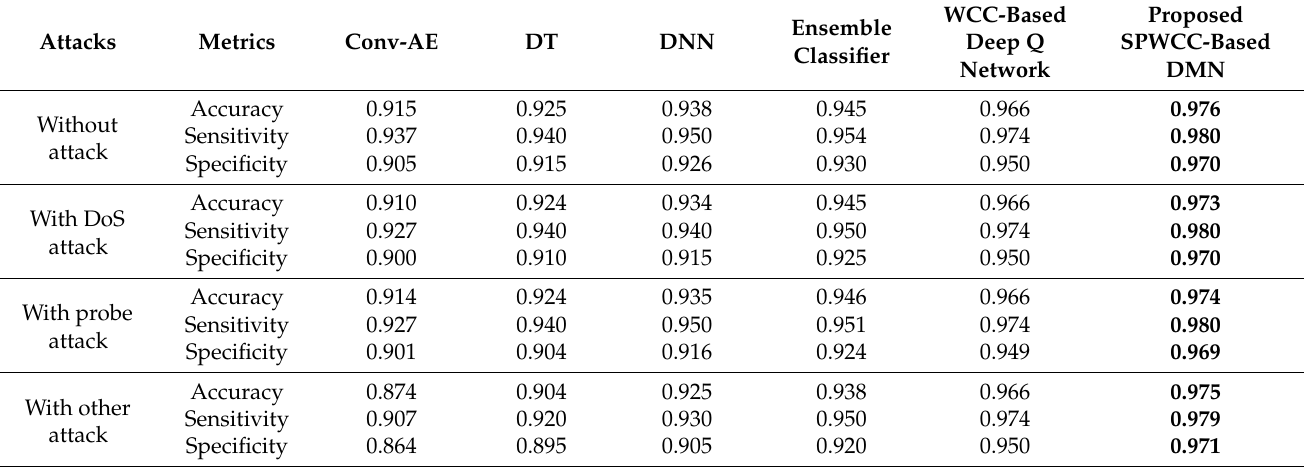
Table 1. Comparative